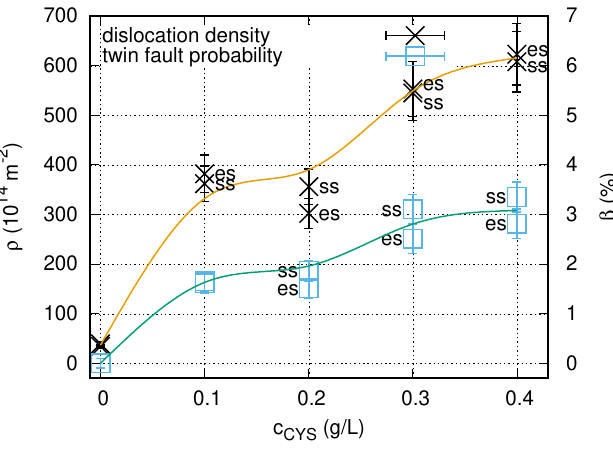
Figure 4. Dislocation density ( ρ ) and twin fault probability ( β ) versus the cysteine content of the bath for the “es” and “ss” sides of the films. The line serves as a guide for the eye only.